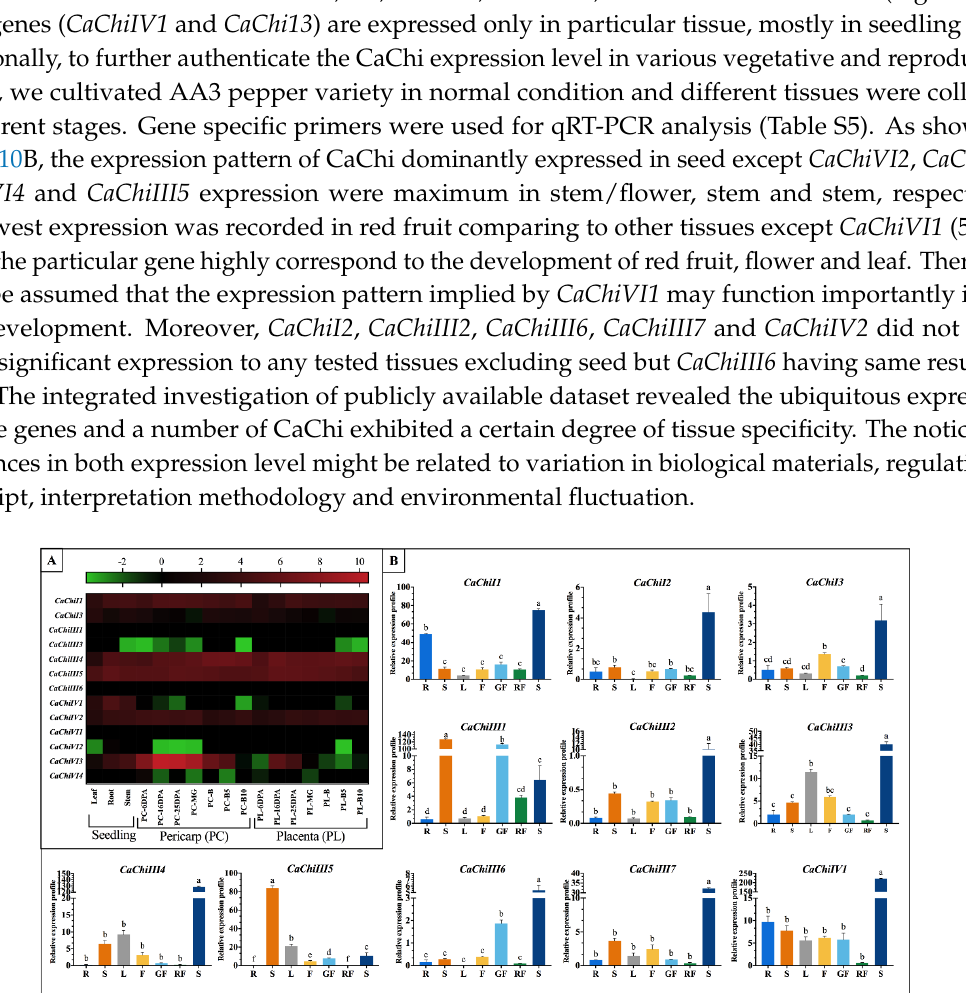
Figure 9. Expression profiles of CaChi in response hormones application. The inducible expression patterns performed by qRT-PCR under Salicylic acid (SA) and methyl-jasmonate (MeJA). Mean values and SDs for three replicates are shown. Small letters (a–f) represent significant differences ( p < 0.05).